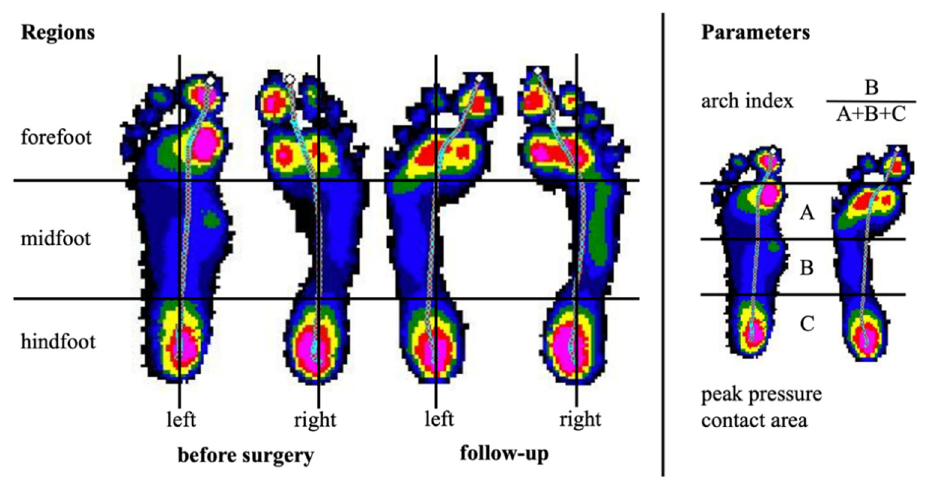
Figure 4. Pedobarographic examination before and after subtalar arthroereises (STA): The foot was longitudinally divided into a medial and lateral zone and transversally divided into a forefoot, midfoot and hindfoot zone resulting in six regions of interest ( left ). Considering flexible flatfoot patterns selected parameters and regions were evaluated (arch index, medial midfoot contact area and medial forefoot peak pressure) ( right ). The pedobarographic analysis demonstrates the reconstitution of physiological and symmetrical foot alignment after STA on the left side (same patient as shown in Figures 2, 3 and 5).